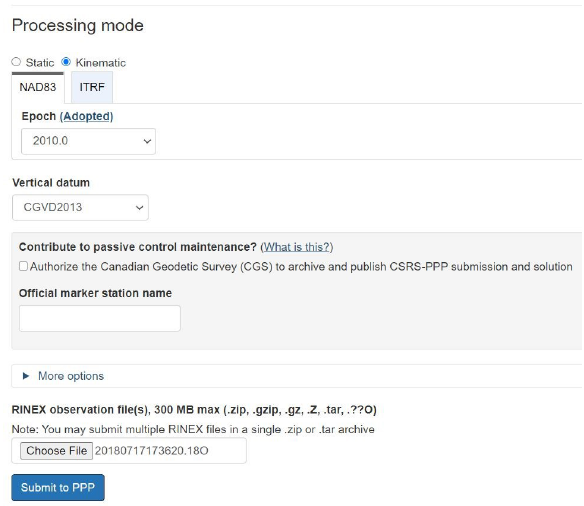
Fig. 6. Data processing parameters used in